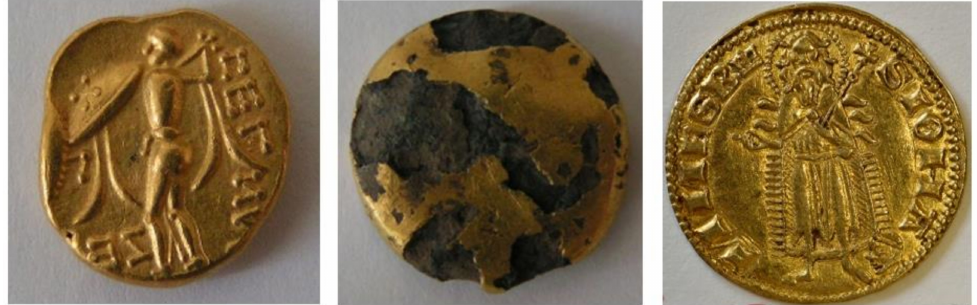
Figure 4. Genuine gold Celtic coin ( left ), fake Celtic coin gilded by a thin layer of gold on a copper alloy core ( middle ), and a genuine medieval gold Hungarian ducat ( right ).